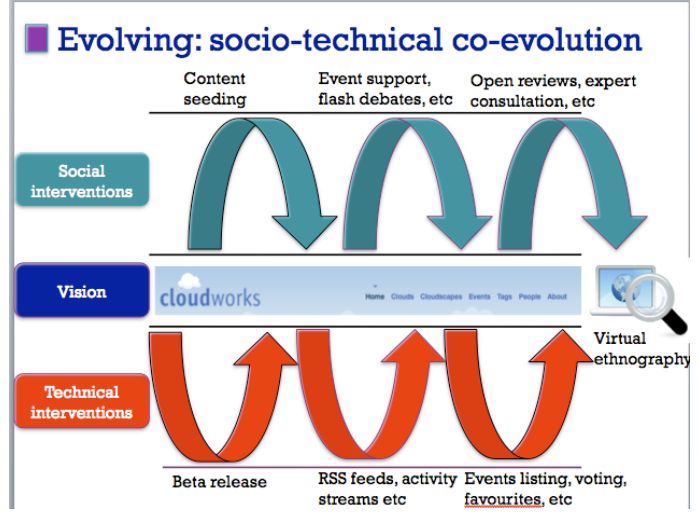
Figure 2 . The approach to development and evaluation of